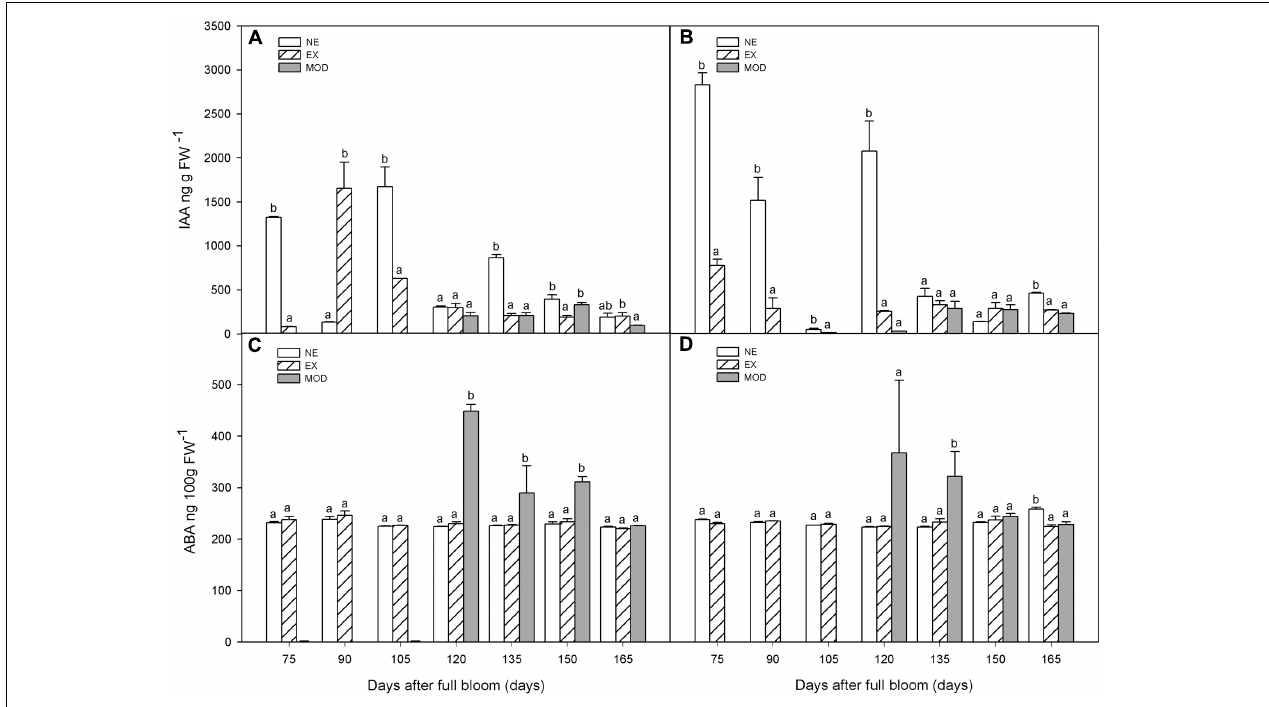
FIGURE 2 | Indol acetic acid (IAA) (A,B) and abscisic acid (ABA) (C,D) concentrations in apple skin during fruit development of non-exposed (NE), exposed (EX), and moderate sun-damaged (MOD) fruit from orchards Quilpue (A,C) and Los Lirios (B,D) , Maule Region, Chile. Different lower-case letters indicate statistical difference ( P ≤ 0.05) between sun damage levels at each time point. Values represent means ± SE of 3 biological replicates.